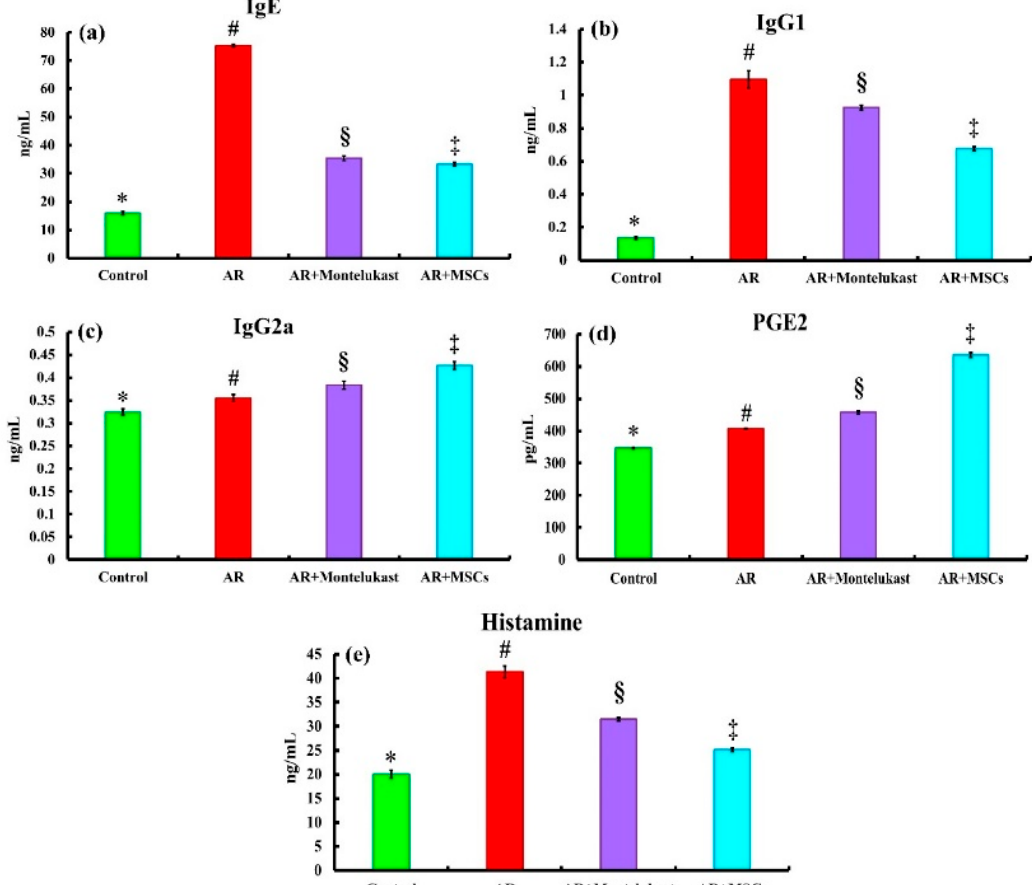
Figure 3. Systemic administration of MSCs decreases the serum levels of antigen-specific-antibody responses. There are significant decreases in OVA-specific IgE ( a ) IgG1 ( b ) and IgG 2 a ( c ), as well as increases in PEG2 ( d ) and histamine ( e ) levels in the sera of rats following the different treatments. Different superscripts (*, #, §, and ‡) indicate significant differences among the experimental groups at p < 0.05. Data are shown as mean ± S.E.M, n = 5–6.